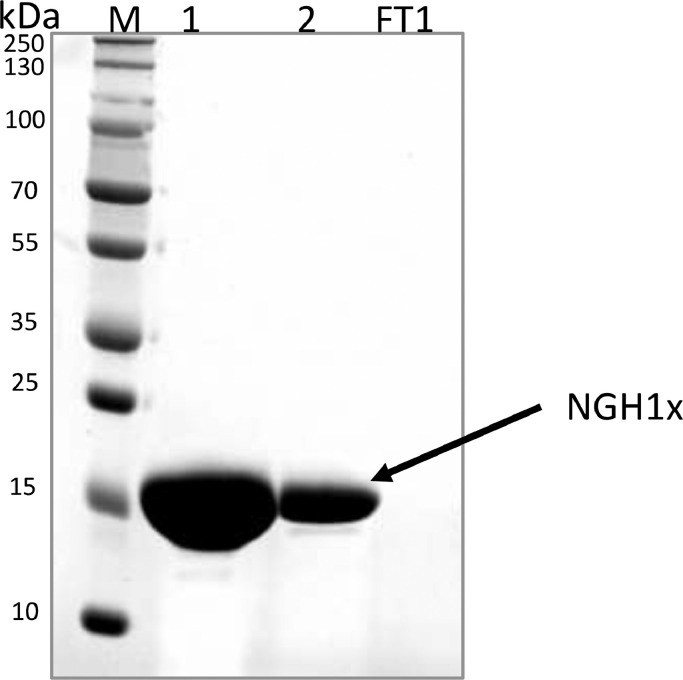
SDS/18% PAGE analysis of purified N15/C13-NGH1x.